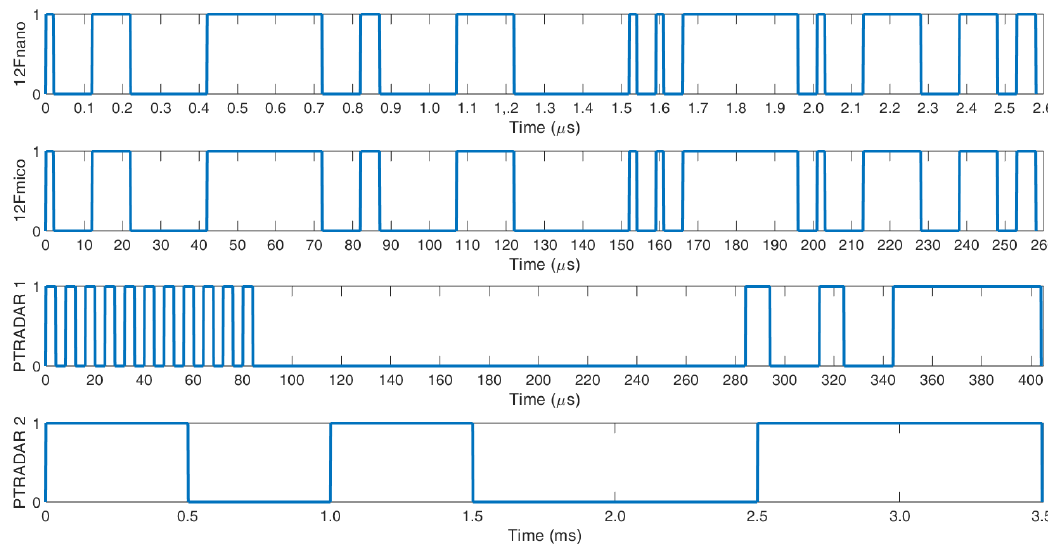
Figure 4. Train pulses used for power amplifier measurements.